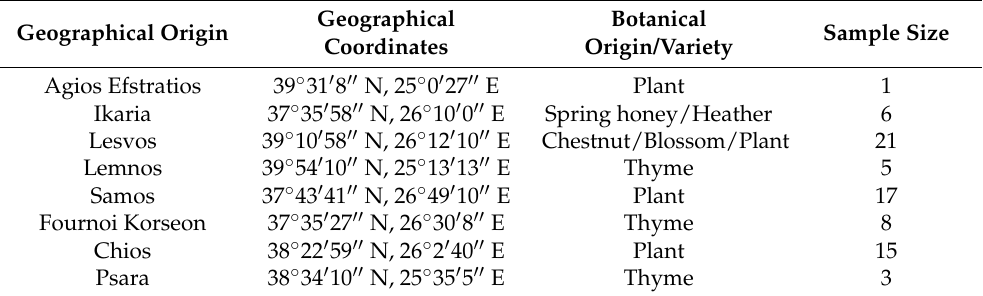
Table 1. List of analyzed honey samples along with their metadata (classification). Geographical Origin